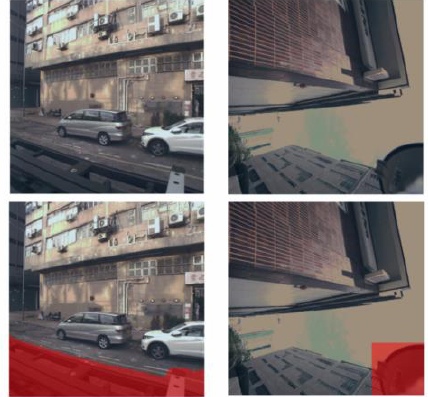
Figure 3. Illustration of the use of image masks. The first row shows original images and the second row shows masks on the images.